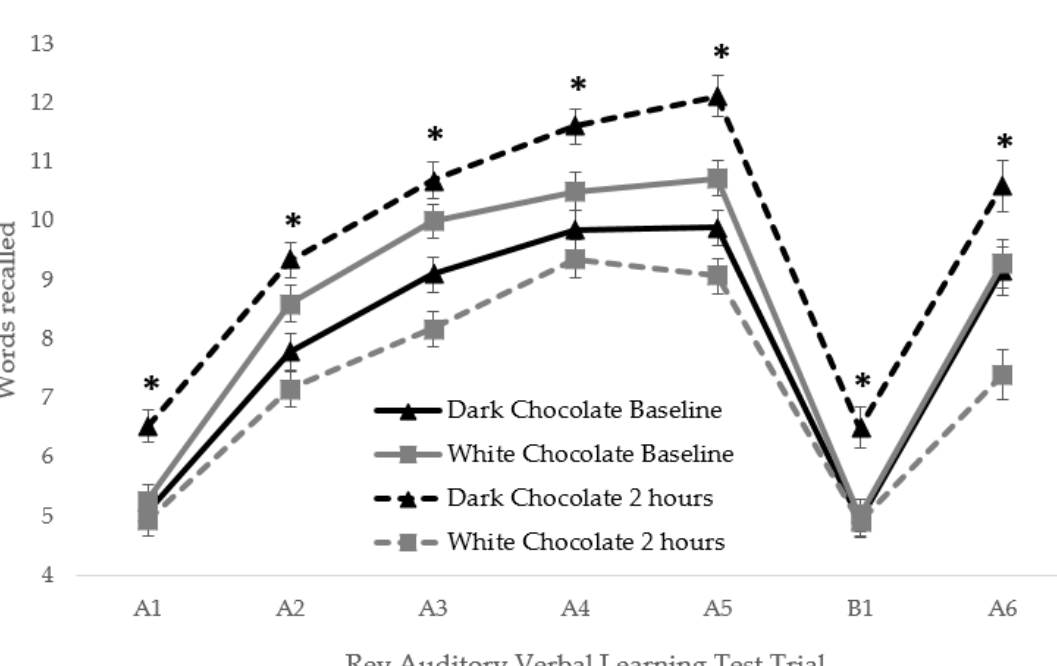
Figure 1. Words recalled (means and standard error) at each trial of the Rey Auditory Verbal Learning Task (AVLT) [19] at baseline and two hours post consumption for the dark chocolate (DC) ( n = 49) and white chocolate (WC) ( n = 49) treatment. An additional Treatment*Session*Trial ANOVA (2 × 2 × 7) revealed a significant three way interaction F (6576) = 4.06, p = 0.001. Post hoc t -tests at each trial were performed comparing DC and WC at baseline, and again at 2 h post consumption. A bonferroni correction for 14 t -tests was applied, and an alpha of <0.003 was considered statistically significant. Significantly better performance following DC relative to WC at 2 h post consumption was observed at all trials, as indicated by an asterix. No significant differences between treatments were seen at baseline.